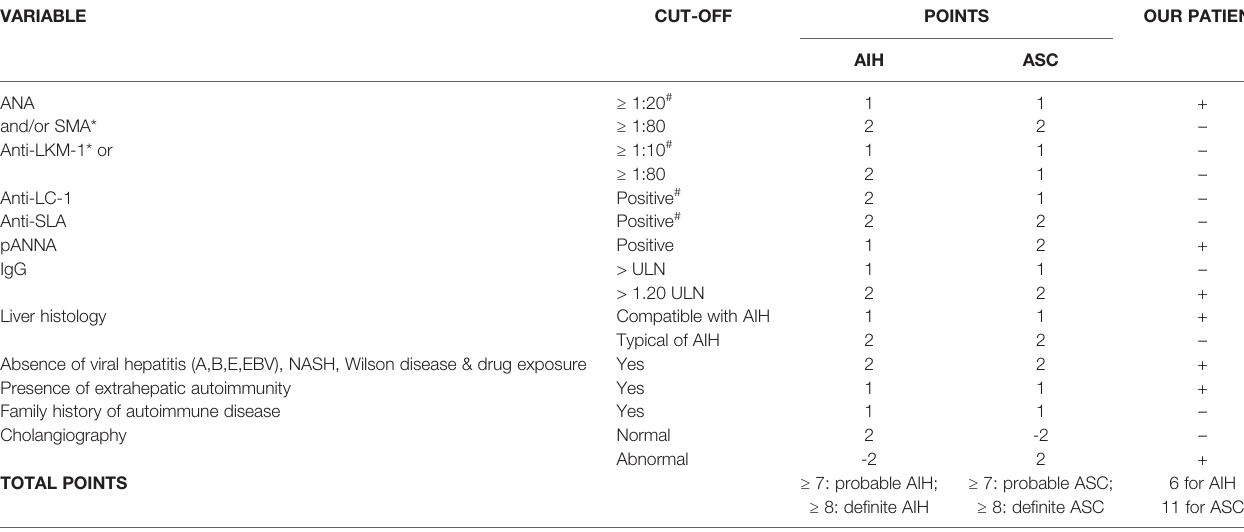
TABLE 3 | ESPGHAN table of scoring criteria for the diagnosis of juvenile autoimmune liver disease (6) and results in our patient.